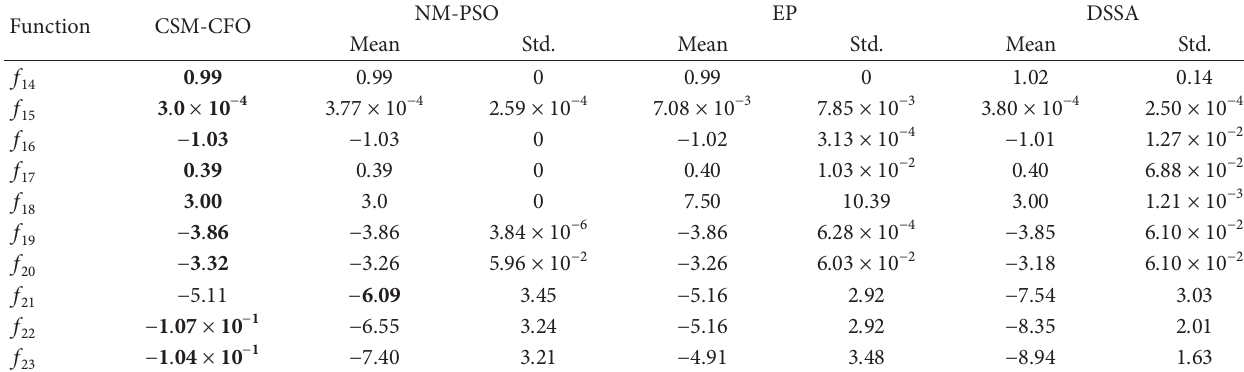
Table 6: Minimization result of benchmark functions in Table 3.